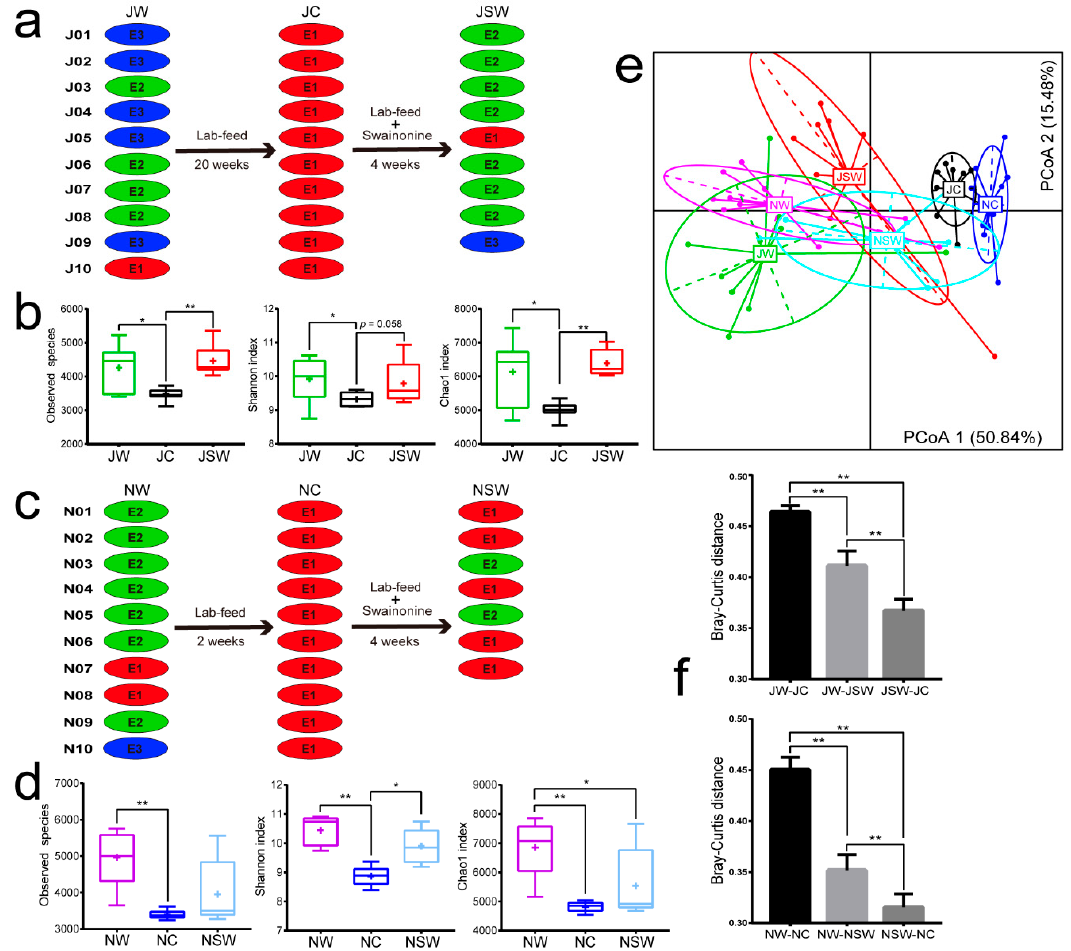
Figure 4. Responses of enterotypes and microbial diversity to interventions. ( a , b ) Changes in and resilience of enterotypes and alpha diversity after long-term dietary intervention. ( c , d ) Changes in and resilience of enterotypes and alpha diversity after short-term dietary intervention. ( e ) PCoA based